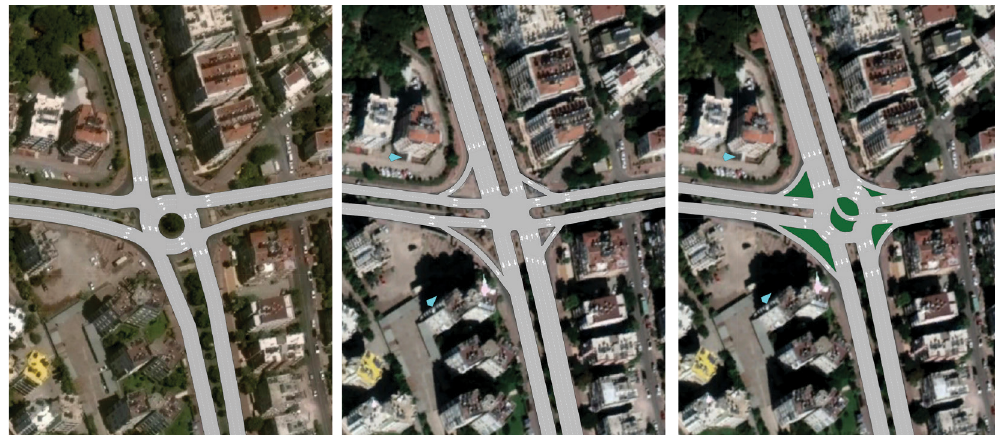
Figure 15. Simulation start images for the roundabout status in 2016, current status and the status as per the proposed roundabout (by maps.google.com)